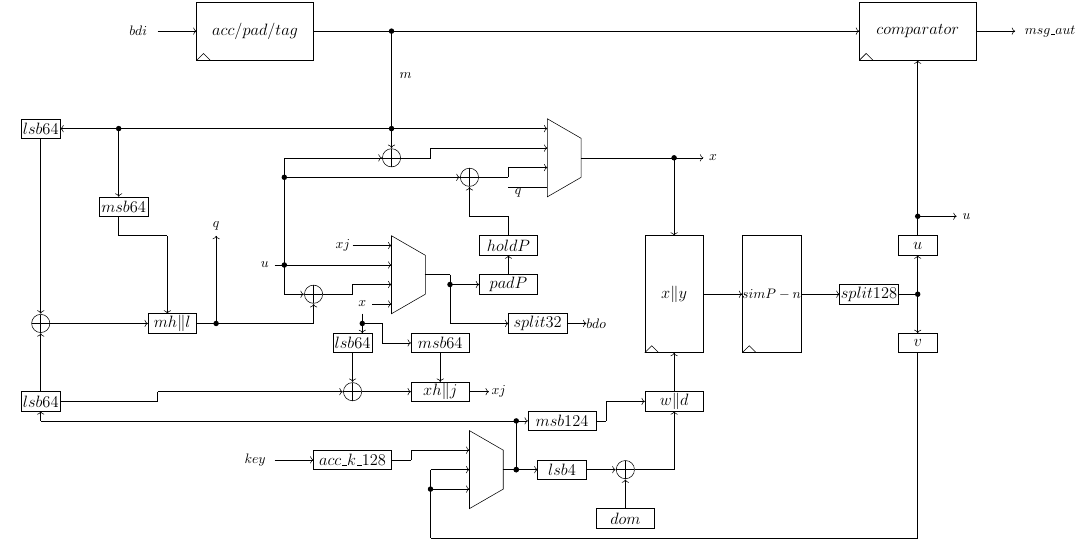
Figure 12. LWC architecture for Oribatida AEAD.